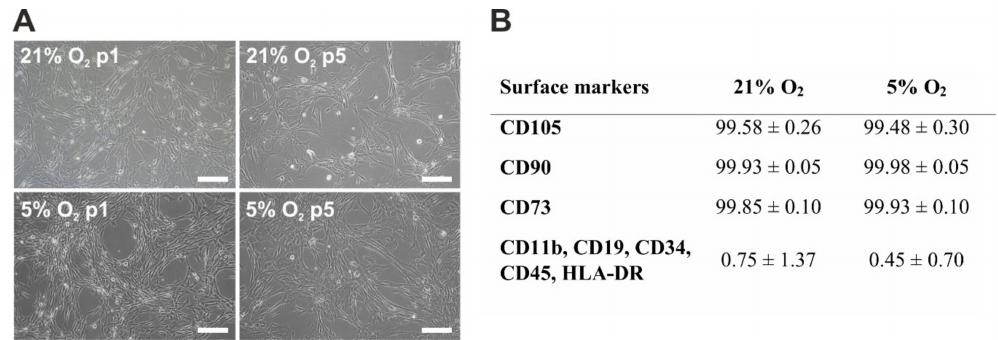
Figure 1. Morphology of the human Wharton’s jelly-derived mesenchymal stem cells (hWJ-MSCs) cultured under 21% O 2 and 5% O 2 (passages 1 and 5). ( A ) Phase contrast images for hWJ-MSC (3) donors are presented as a representative (scale bars: 100 µ m). ( B ) Cell immunophenotype results are expressed as the mean ± SD of 4 investigated donors.